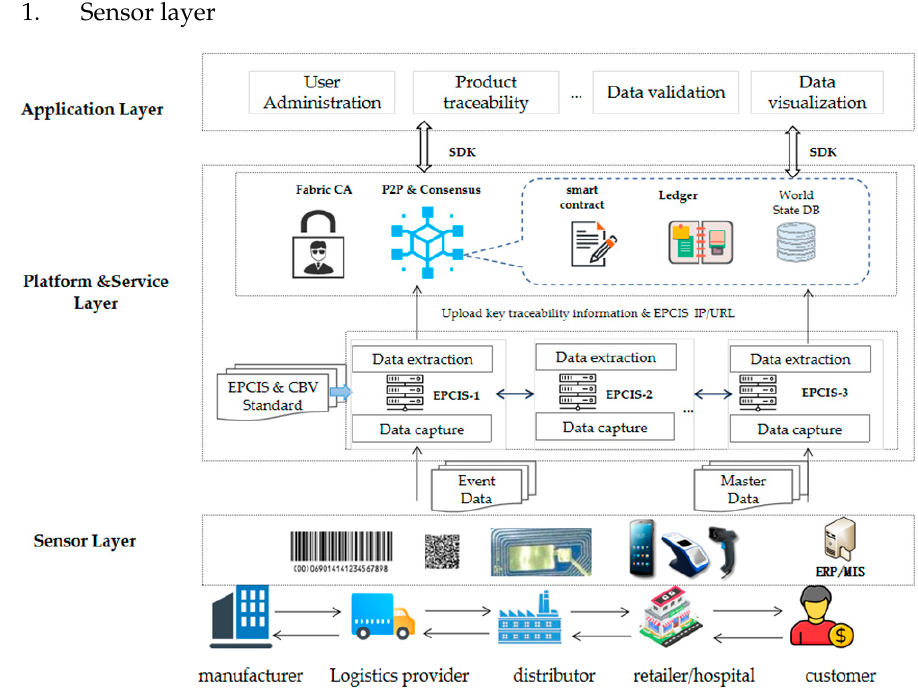
Figure 1. Architecture of the product traceability system based on hyperledger fabric and